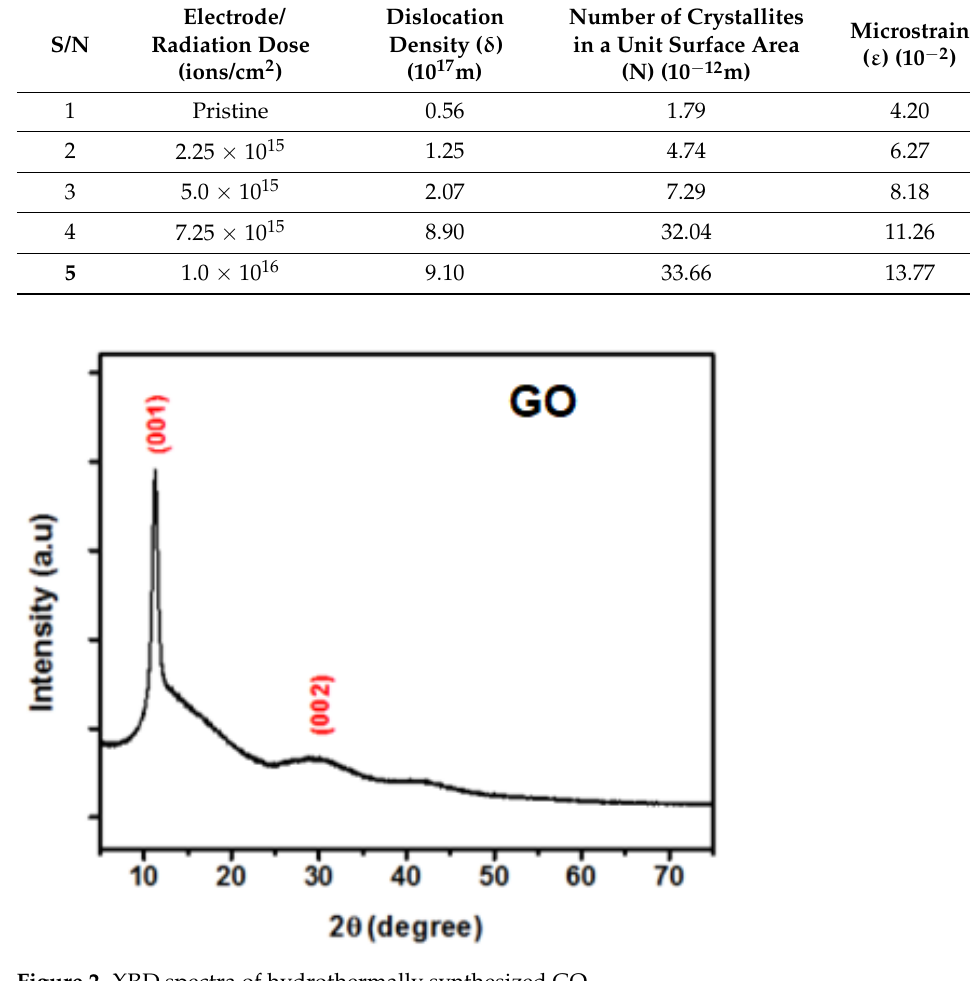
Figure 3. XRD spectra of Co 3 O 4 @MnO 2 @NiO/GO electrodes. 3.2. Surface/MorphologicalAnalysis The morphology and microstructure of Co 3 O 4 @MnO 2 @NiO/GO electrodes were stud- ied using SEM. Figure 4a is the SEM image of the pristine electrode, which demonstrates that the pristine electrode possesses a mixture of flake and granular particles evenly dis- tributed on the surface of the substrate. The shapes were randomly distributed on the surface of the substrates. These flake- and granular-shaped particles are small in nature, which can be credited to the condensed crystallite feature of these particles. On the other